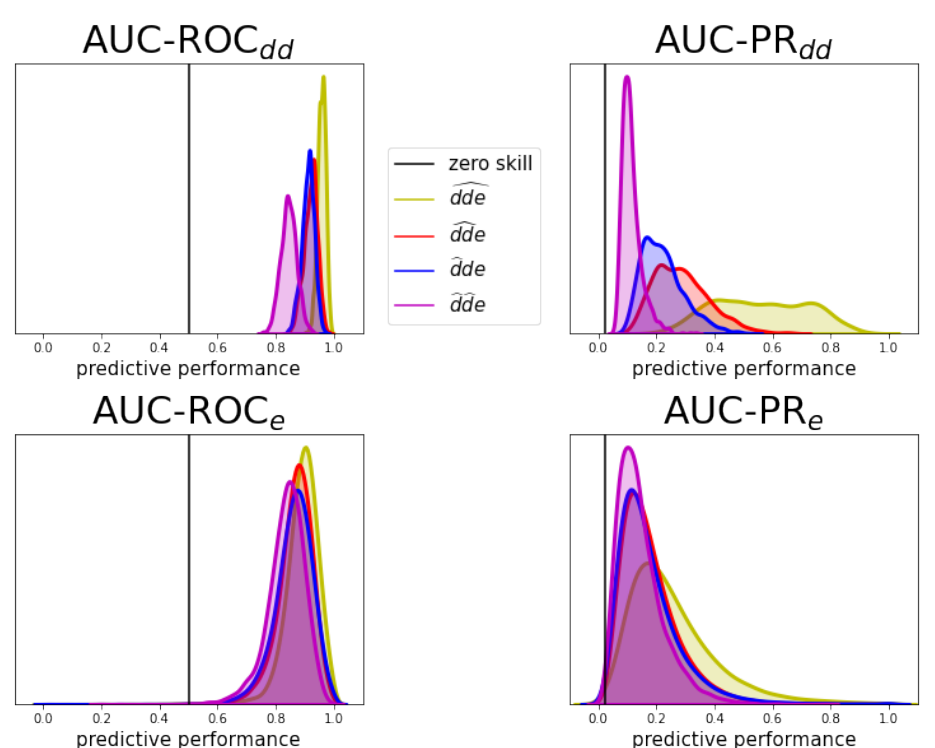
Figure 4. Normalized performance distributions for the different prediction tasks, obtained as illustrated in Figure 3 for both evaluation schemes. The test predictions of the ten folds were pooled together into one final evaluation such that each distribution is unambiguously determined. No-skill performance for AUC-ROC and AUC-PR is 0.5 and 0.02, respectively. Details on the computation and the no-skill value of AUC-PR can be found in Appendix D. Both metrics have perfect-skill performance at